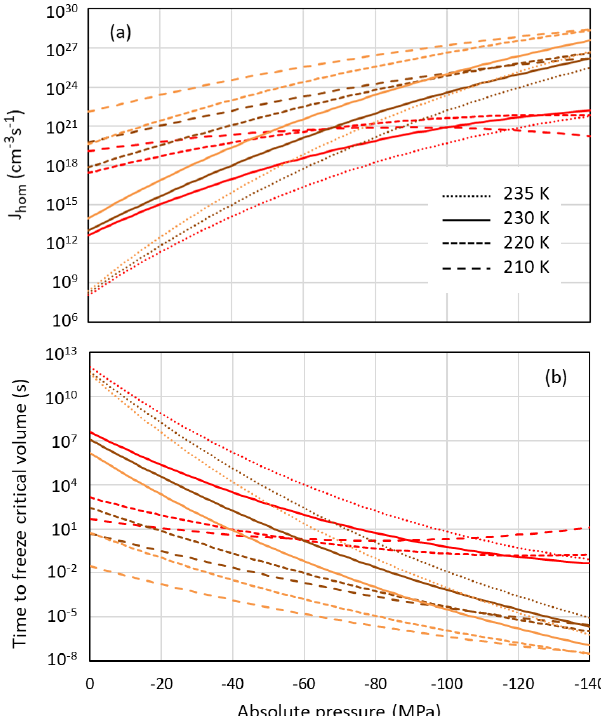
Figure 8. Pressure dependence of homogeneous nucleation rates (a) and the time to freeze the critical water volume for homogeneous ice nucleation (b) at four different temperatures as indicated in the legend. Ick15 is shown in red and Mr10 in orange for n = 0 . 97 and in brown for n = 0 .